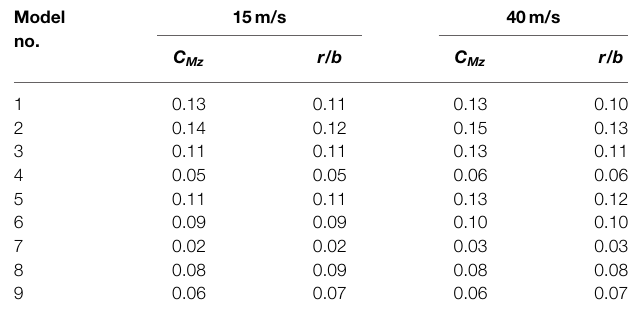
TABLE 4 | Twisting moment coefficient and eccentricity ratio results. Model no.